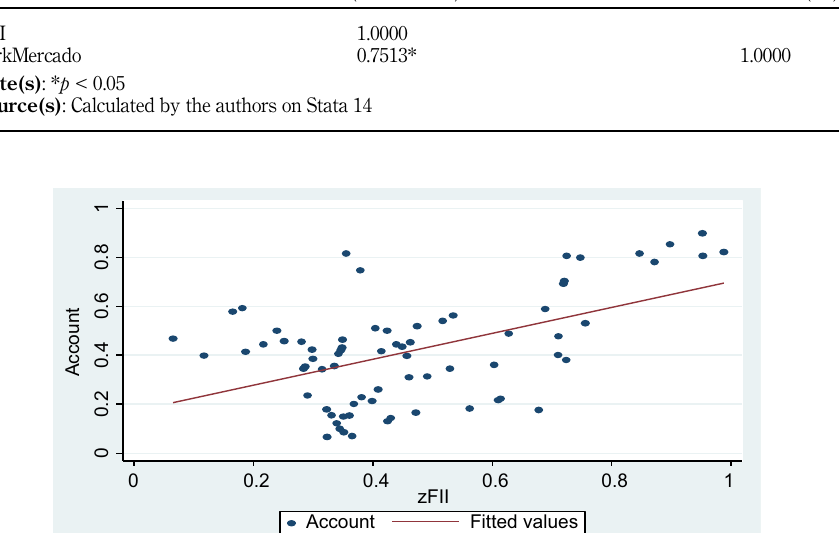
Figure 3. FI index and household-based indicator